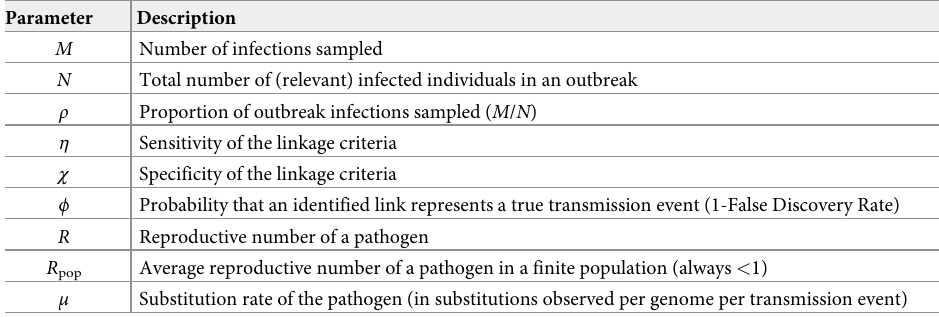
Table 1. Parameters used in calculations and